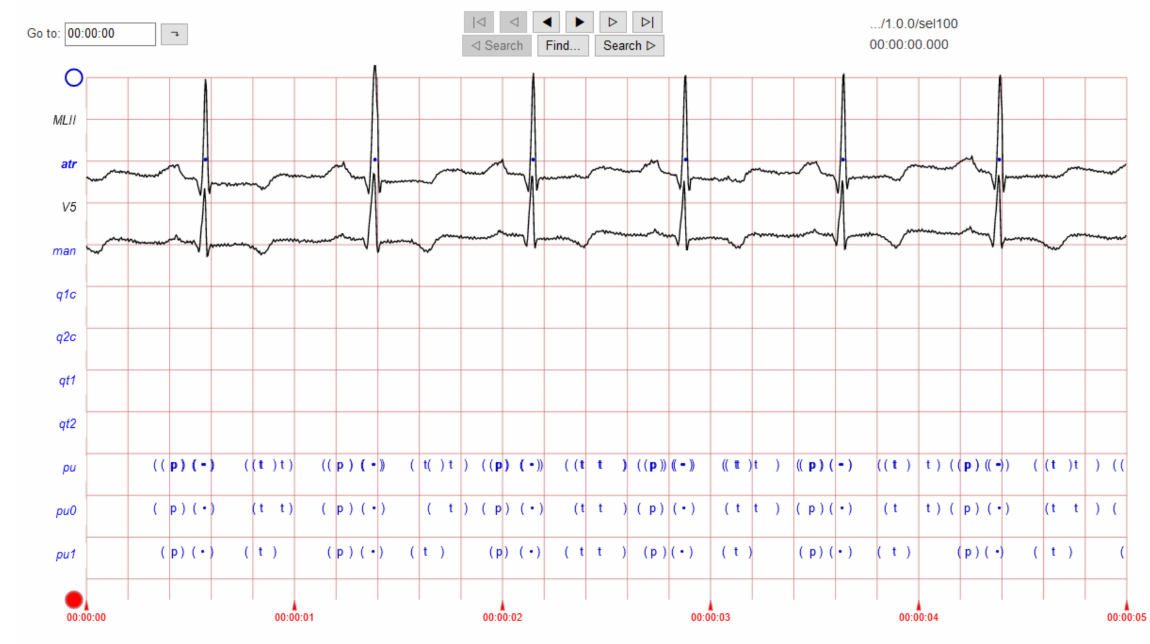
Figure 1. ECG image data for ‘normal sinus’ waveform.